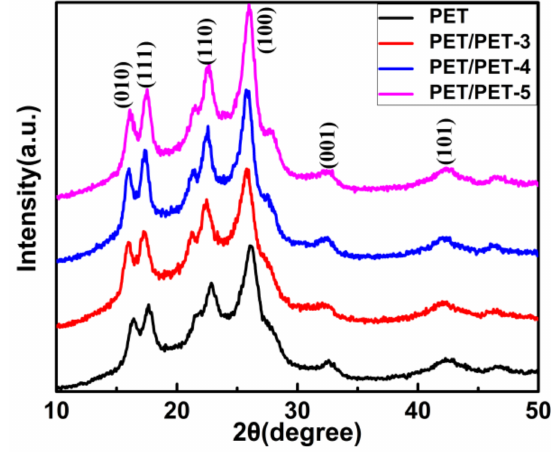
Figure 6. The XRD patterns of PET, PET/PET-3, PET/PET-4 and PET/PET-5.